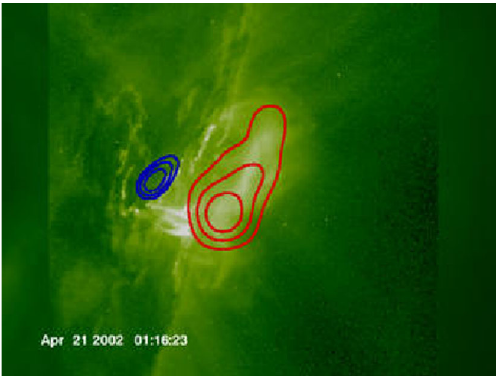
Fig. 4 Still from a movie: Zooming into the active region that hosted the major flare SOL2002-04-21. The movie starts in white light observed by the SOHO/MDI instrument, adds the coronal images observed by the SOHO/LASCO coronagraph, then changes to extreme ultraviolet observed by SOHO/EIT and later by the TRACE satellite, and later the RHESSI observations of the flare in soft X-rays ( red ) and hard X-rays ( blue ). The focus then goes to the associated coronal mass ejection observed by the coronagraph.The movie ends in a storm of streaks produced by energetic flare particles (mostly protons), hitting the detectors on the Solar and Heliospheric Observatory (SOHO) in space. Visualization by RHESSI